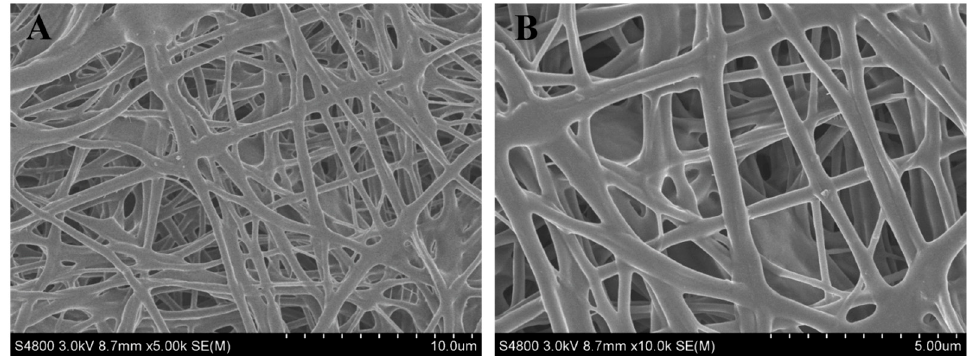
Figure 5. SEM images of electrospun nanofibers of P1 ( A ) and P2 ( B ) after annealing at 47 °C.